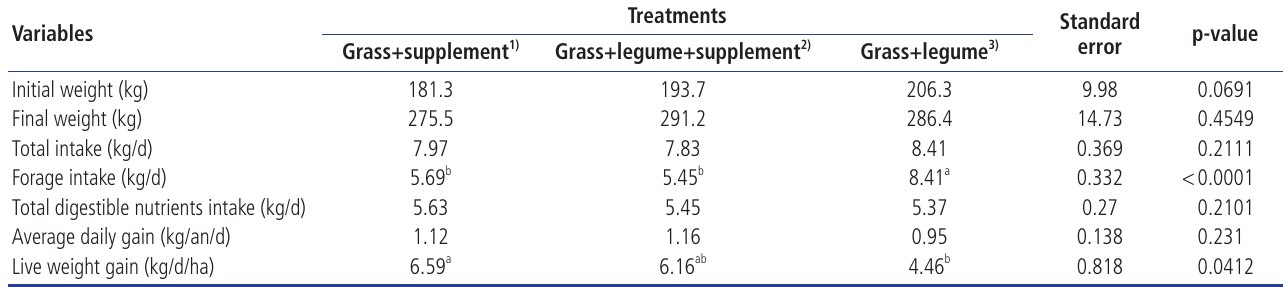
Table 3. Averages for initial and final weight, dry matter intake, average daily gain and live weight gain per area of beef steers in oat and ryegrass pastures mixed or not with vetch and with or without energy supplementation Variables